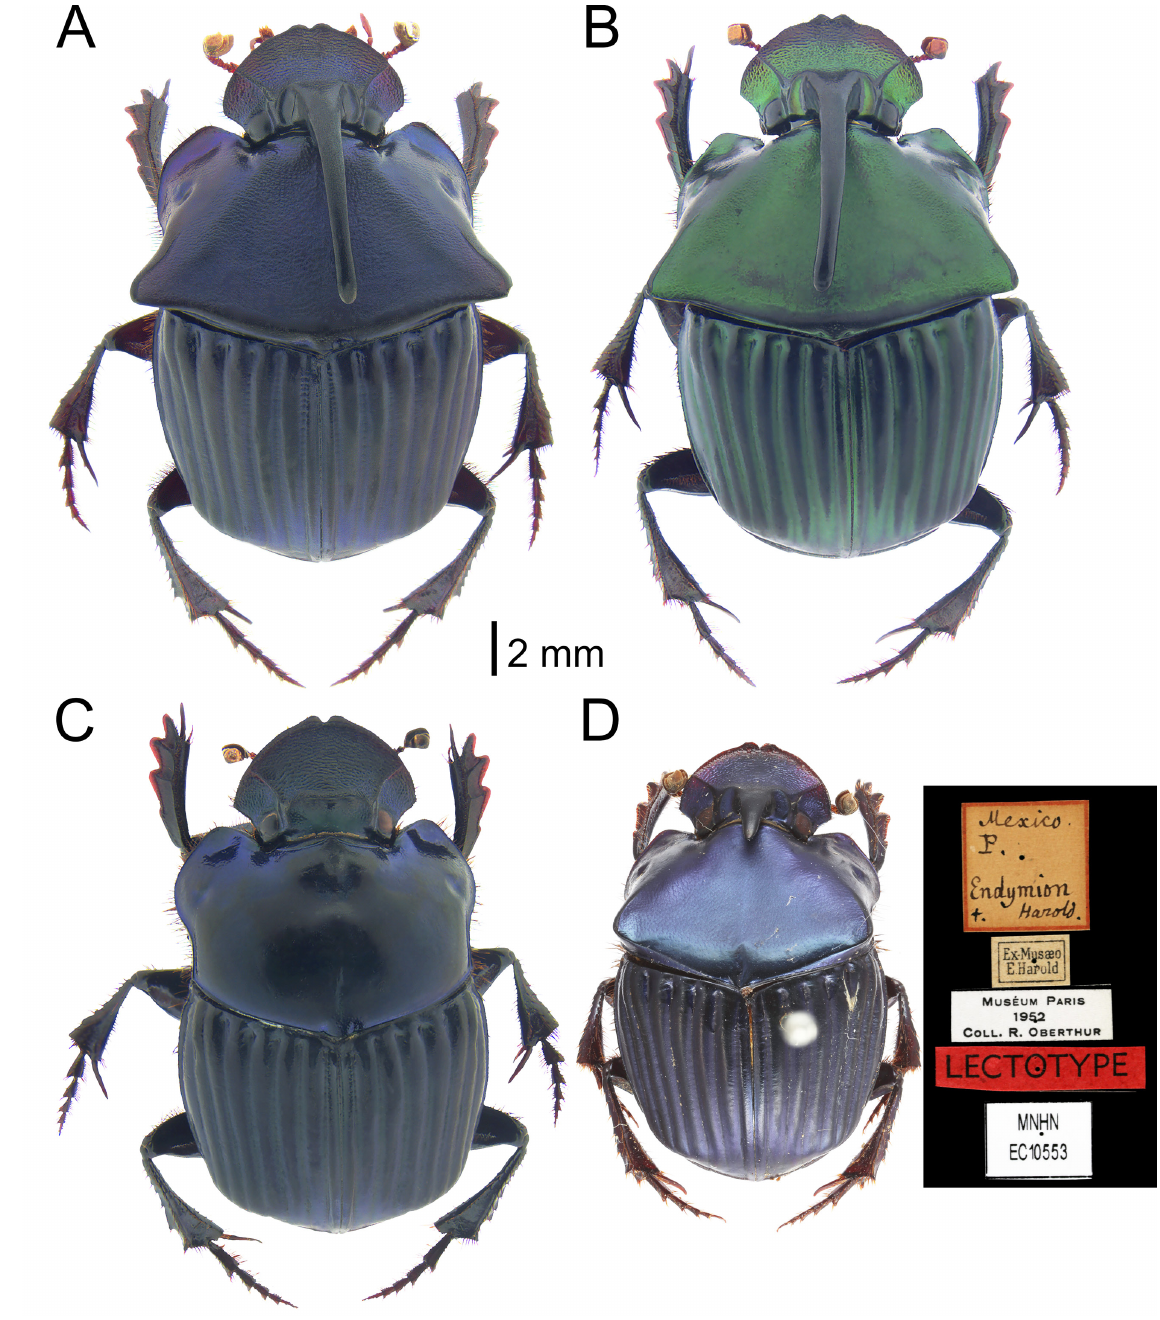
Fig. 4. Phanaeus endymion Harold, 1863. A . ♂, blue morph (typical; VMC). B . ♂, green morph (VMC). C . ♀, blue morph (typical; VMC). D . Lectotype, ♂ (by Christophe Rivier, Muséum national d’histoire naturelle, Paris, France)